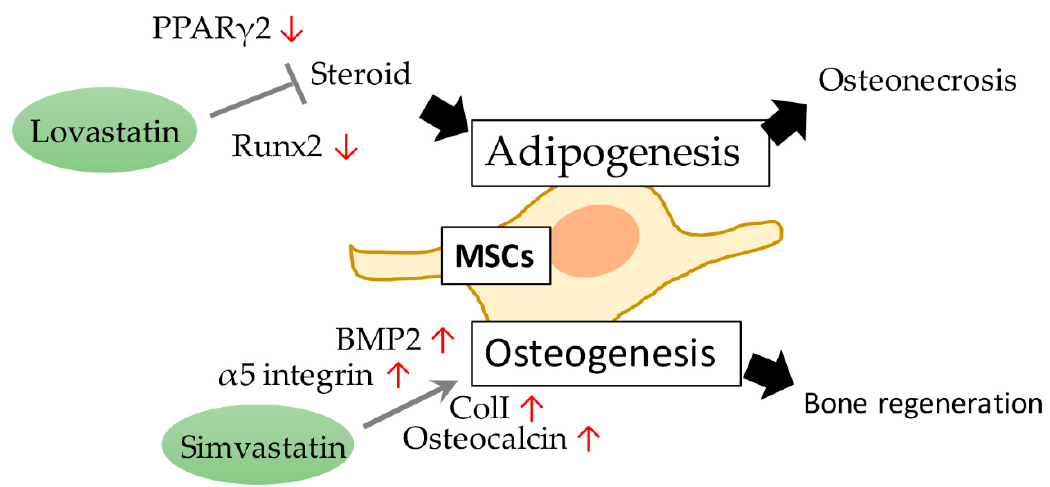
Figure 6. The lipid-lowering drugs lovastatin and simvastatin prohibit adipogenesis and osteogenesis, respectively, to manipulate MSC cellular